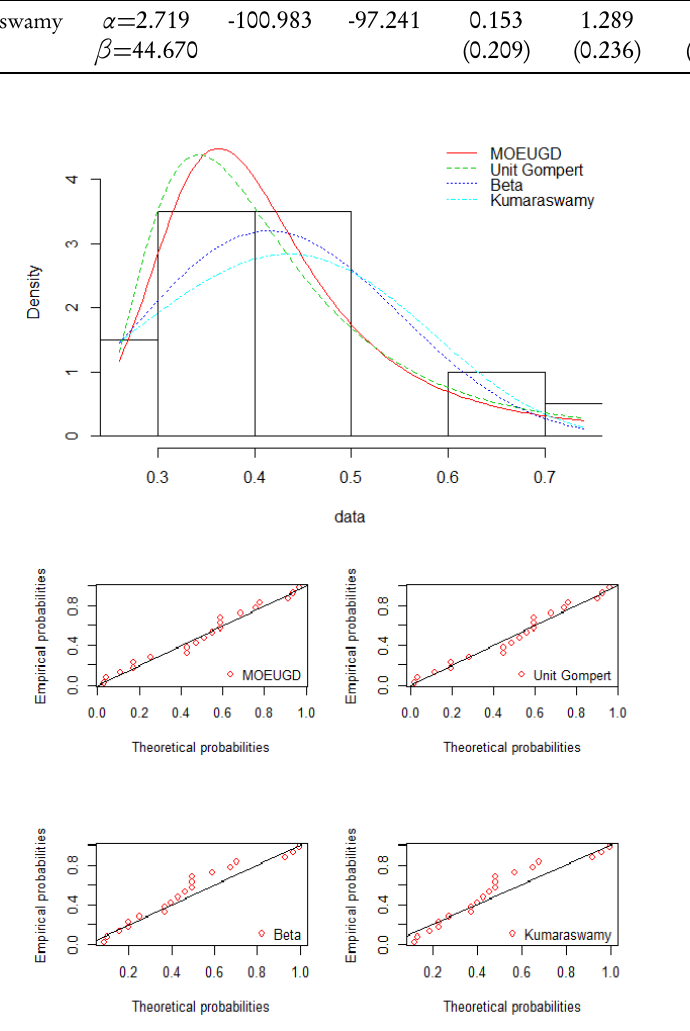
Figure 3 – Density fit and P-P plots of the distributions for the Flood level